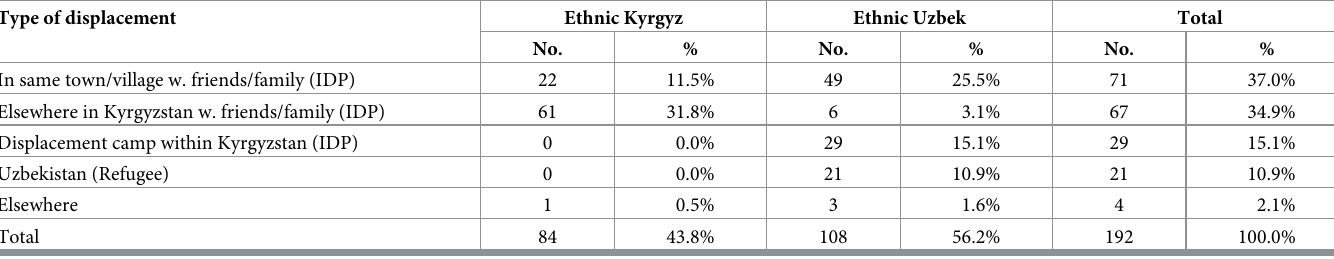
Table 1. Forms of